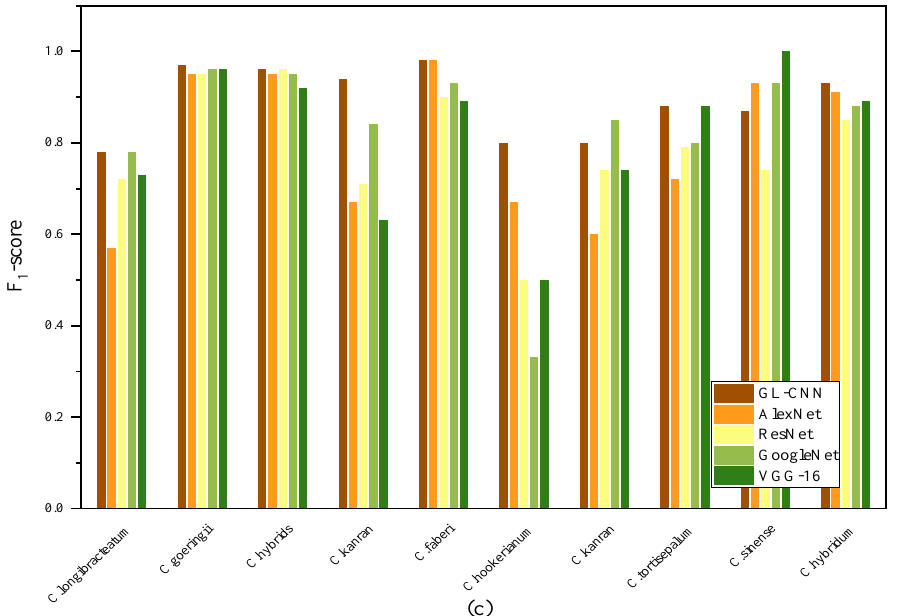
Figure 6. Precision ( a ), recall ( b ), and F1-score ( c ) of each model on different Cymbidium species. Table 2. Average accuracy of each model.